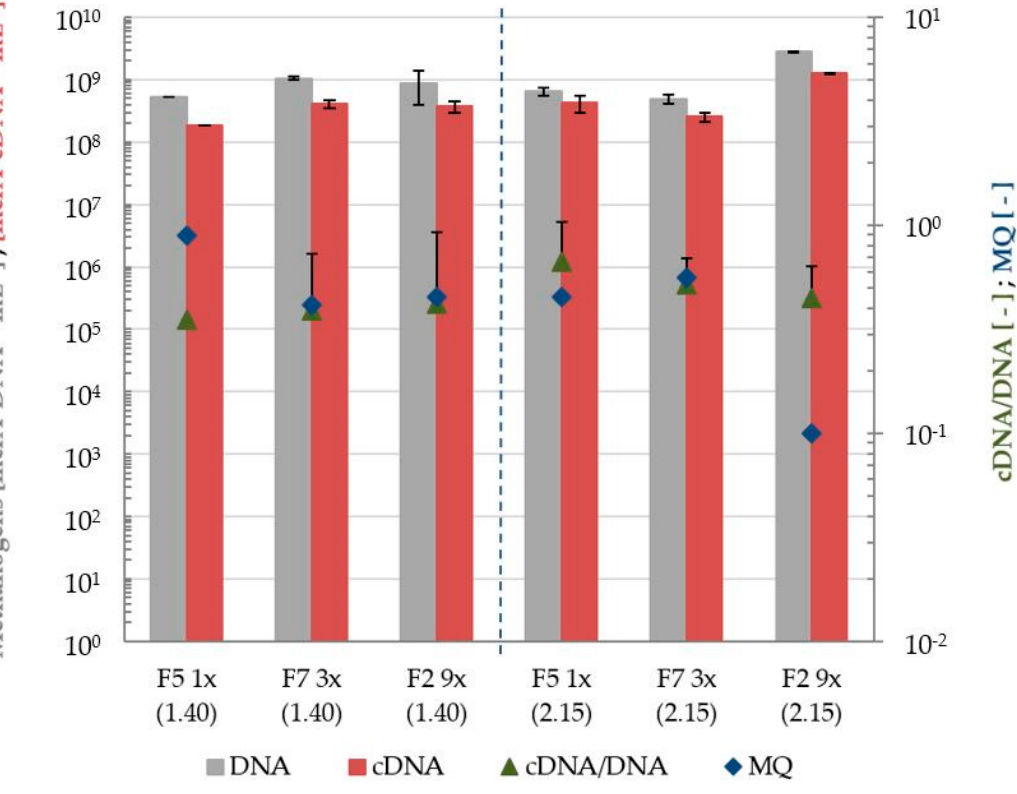
Figure 6. mcrA 1,2 DNA and cDNA concentrations, T / GmcrA 1,2 ratios and metabolic quotient (MQ) values in the di ff erently fed fermenter sludges.